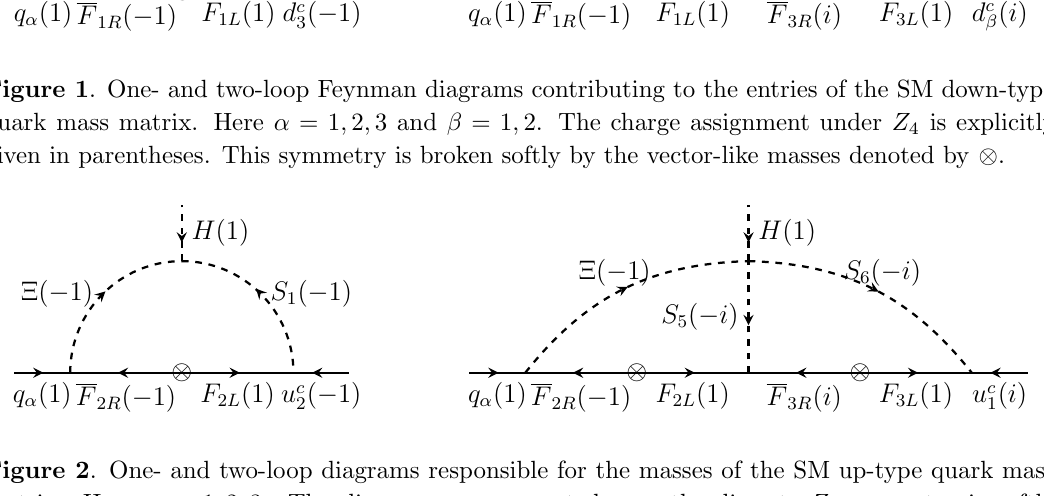
Figure 2 . One- and two-loop diagrams responsible for the masses of the SM up-type quark mass matrix. Here (cid:11) = 1 ; 2 ; 3. The diagrams are generated once the discrete Z 4 symmetry is softly broken by the fermion masses, denoted by . The charges under Z 4 are given between parenthesis (cid:10) next to the corresponding